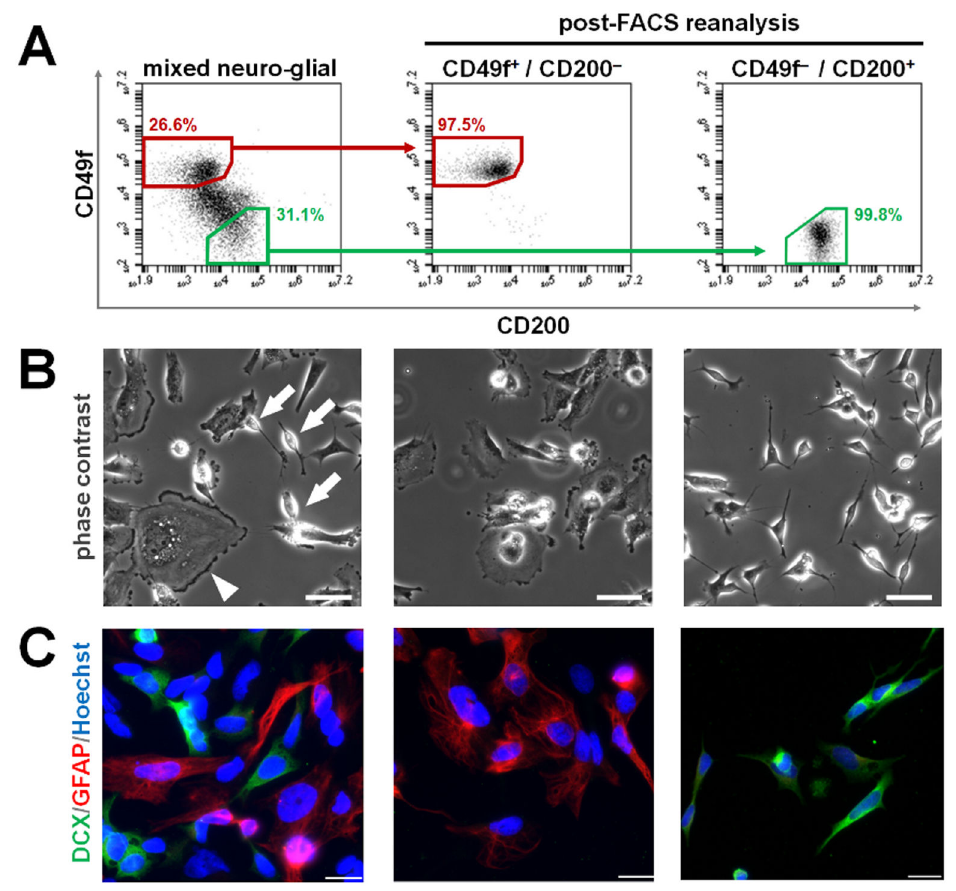
Figure 7. Application for neural cell isolation in human neural cancer lines. ( A ) Mixed SH-SY5Y/SNB-19 neuro-glial cell suspensions (without fixation and permeabilization) analyzed by flow cytometry for CD49f-PE and CD200-APC. Polygon gates within the left dot plot indicate selection of CD49f + /CD200 - (red) versus CD49f - /CD200 HIGH (green) populations. ( B ) Corresponding microscopic analysis of unsorted (left panel) vs. sorted conditions (mid and right panels) 1 div post-sort. Arrows indicate SH-SY5Y cells, arrowhead SNB-19 [phase contrast; scale bars: 50µm]. ( C ) Immunofluorescence for GFAP (red) and doublecortin (green) of surface marker code-based cell suspensions. Left panel: unsorted; mid panel: CD49f + /CD200 - population post-sort; right panel: CD49f - /CD200 HIGH population. [1 div post-FACS; scale bars: 20µm]. doi: